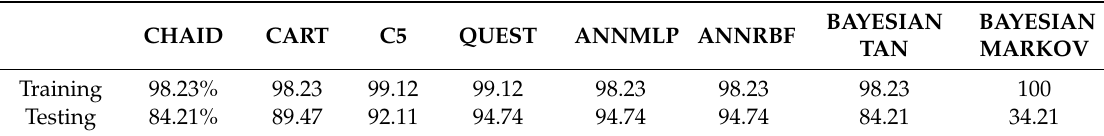
Table 3. Overall accuracy of the models employed.